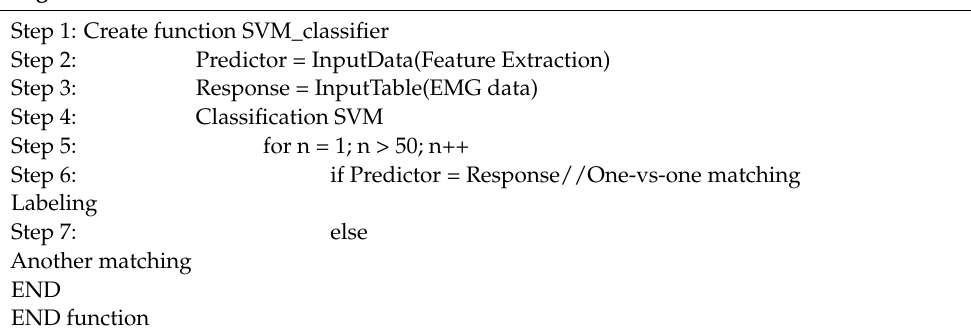
Algorithm 1 SVM based on EMG data